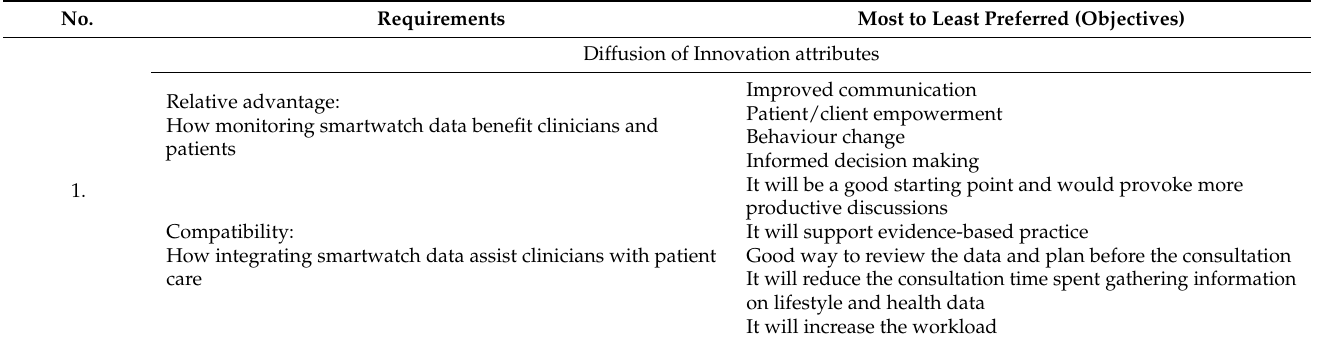
Table 1. Requirements and objectives resulting from the co-design